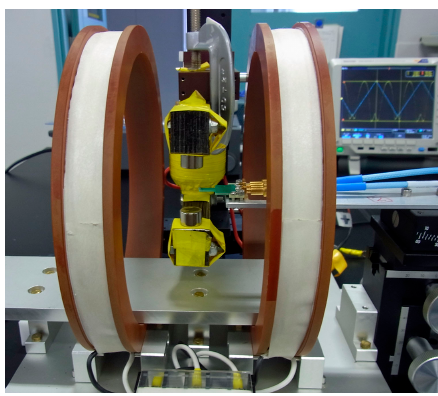
Figure 9. Photograph of the measurement apparatus with applying normal field.